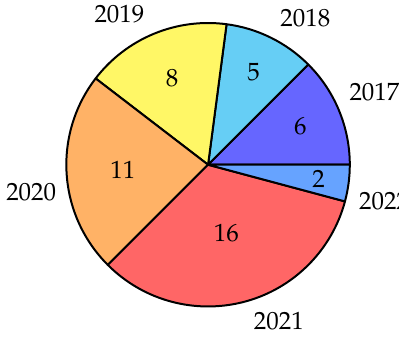
Figure 3. Publication by year (for the 48 total articles).